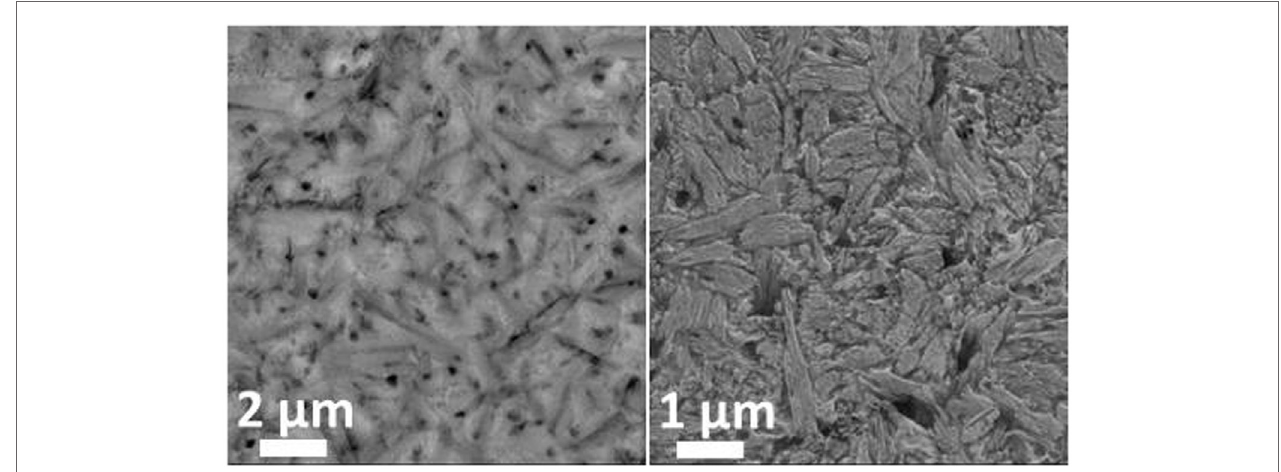
FigUre 5 | Microstructure of glass-ceramic g . Left: backscattered electrons; right: secondary electrons.